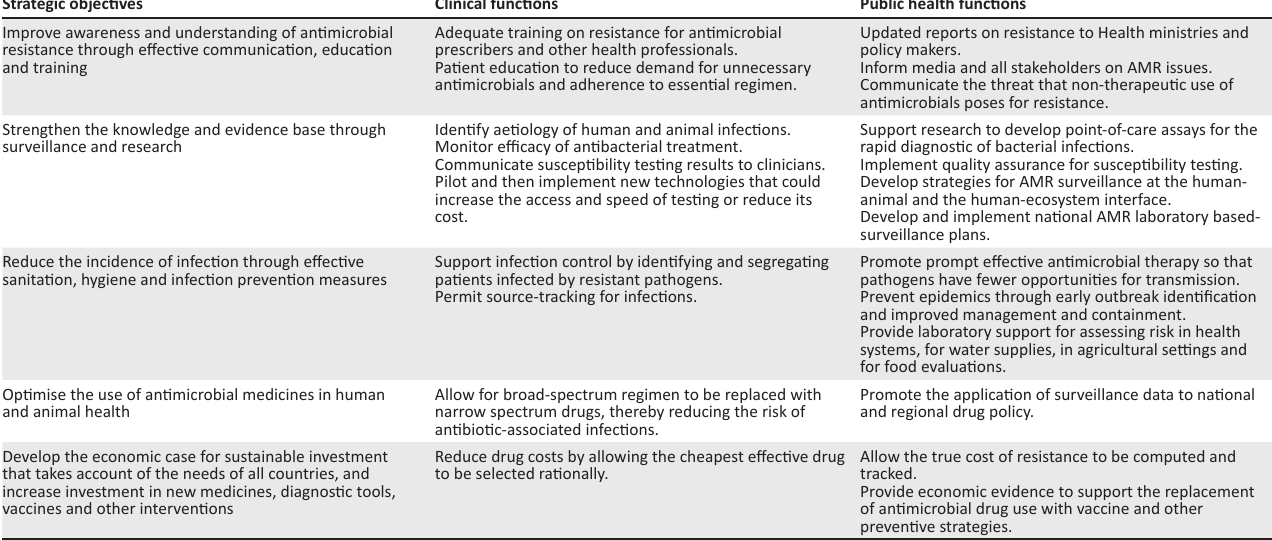
TABLE 1: The role of the laboratory system in meeting the objectives of the World Health Organization global action plan on antimicrobial resistance. Strategic